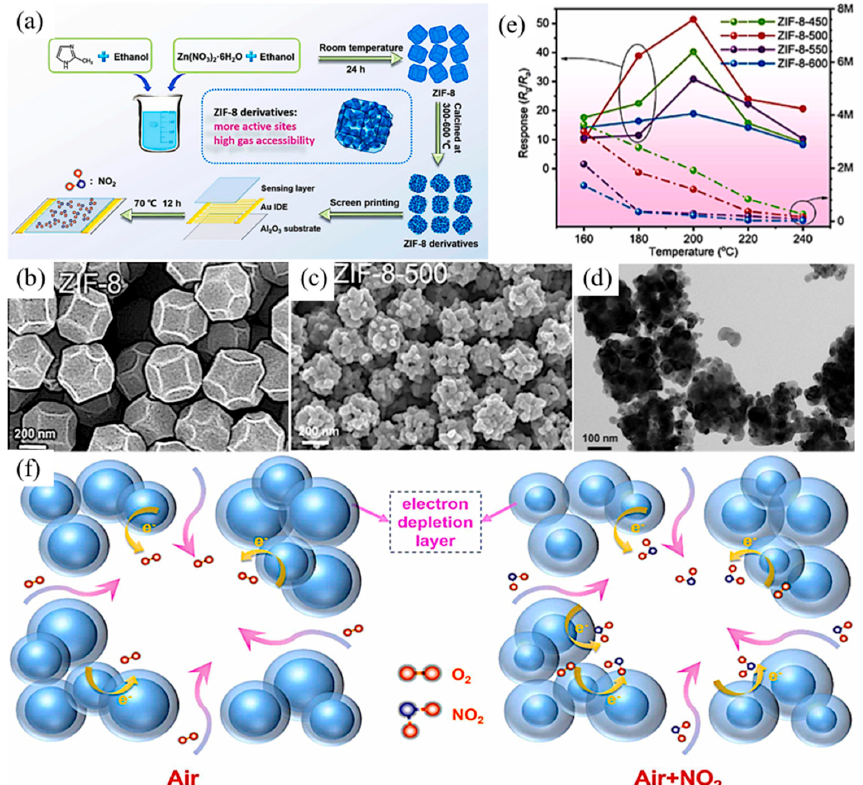
Figure 1. ( a ) Schematics of the synthesis and fabrication process of a ZIF-8 derivatives-based sensor; SEM images of ( b ) ZIF-8 and ( c ) ZIF-8 derivatives after 500 °C pyrolysis; ( d ) TEM images of porous ZIF-8-500; ( e ) Response value to 1 ppm NO 2 at different operating temperatures of ZIF-8-derivatives after different pyrolysis processes; ( f ) Mechanism for the NO 2 sensing process of ZIF-8-500 [65].